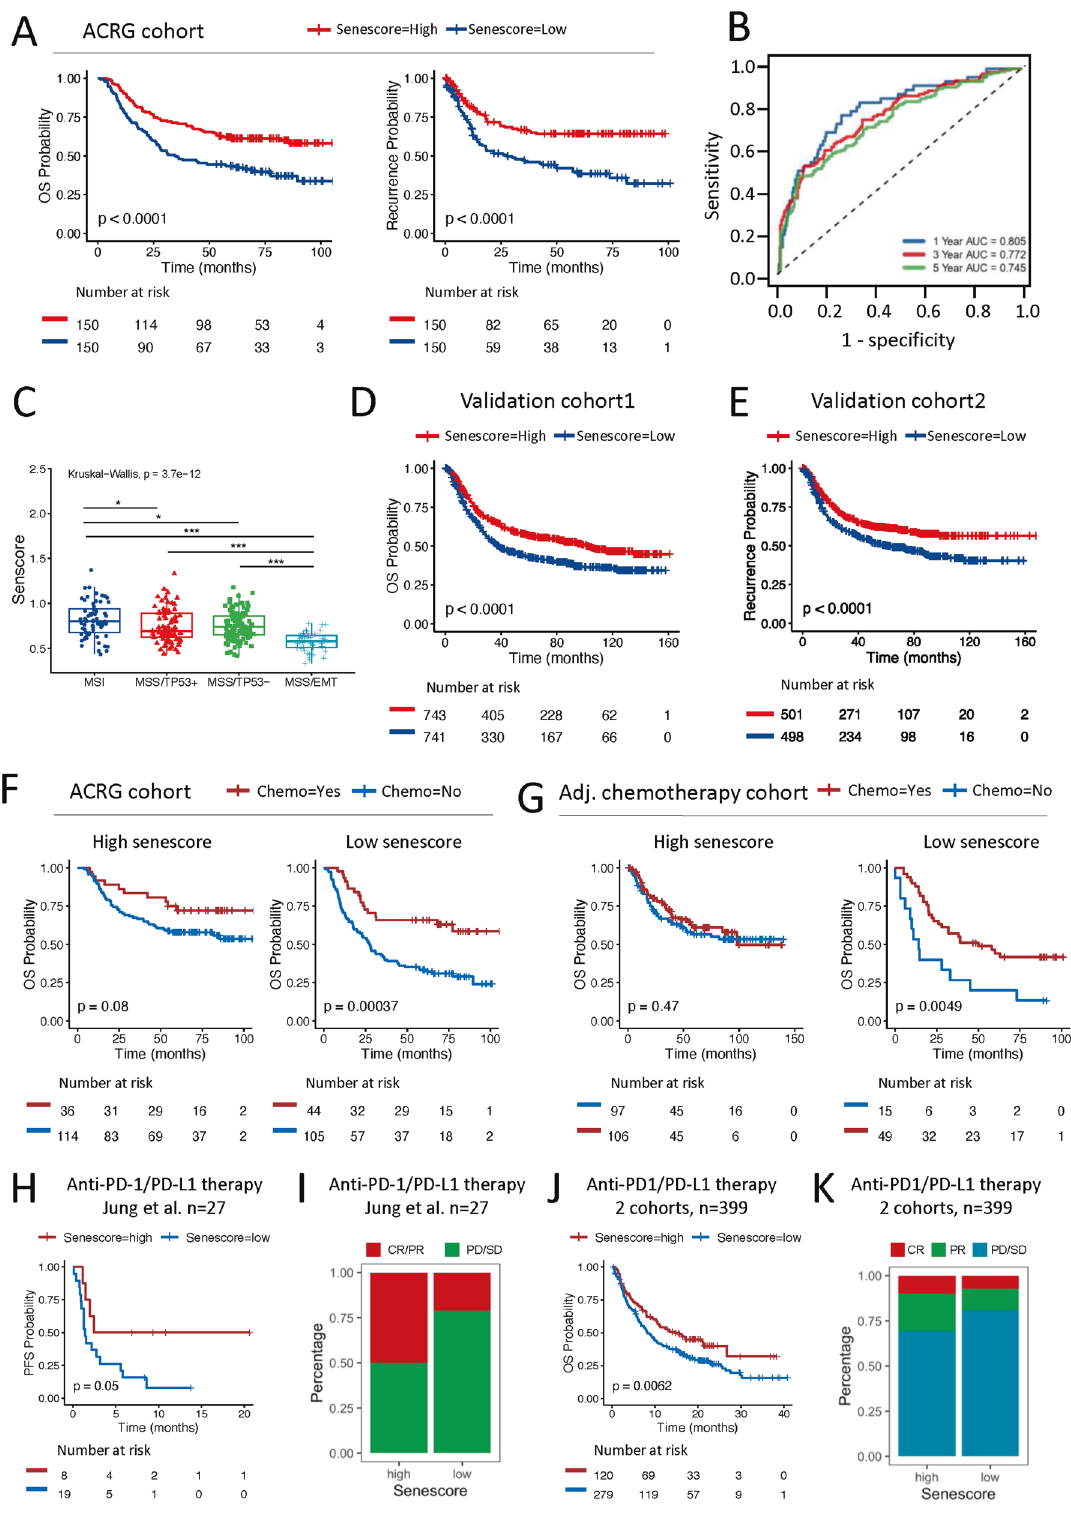
cores on the slide consisted of 90 cases of gastric cancer tissue and paired normal gastric tissue. The detailed clinical information was summarized in Table S7. All tissues were collected in accordance with the ethical standards with the donor being informed completely and with their consent, from National Human Genetic Resources Sharing Service Platform: